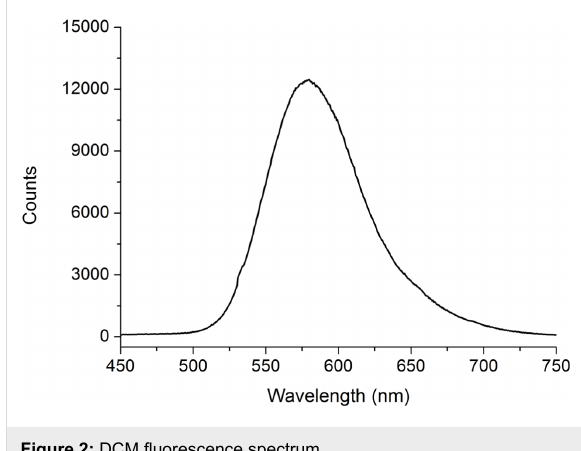
Figure 2: DCM fluorescence spectrum.